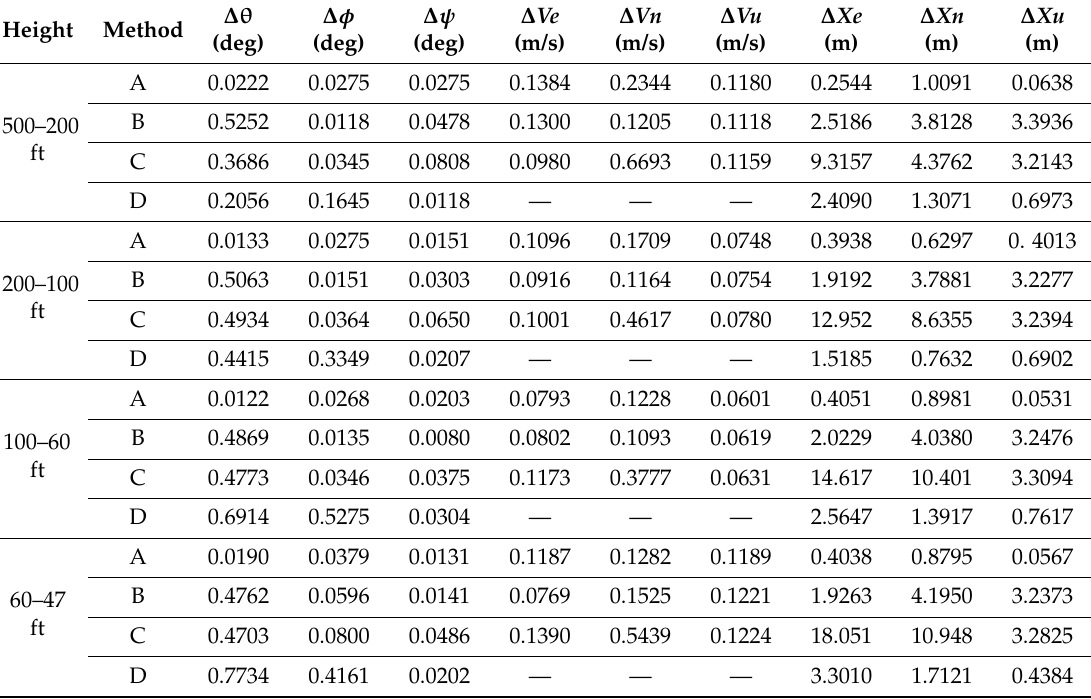
Table 3. RMS Errors of attitude, velocity and